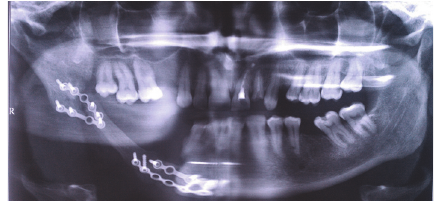
Figure 3: Panoramic radiography, next day after surgery.